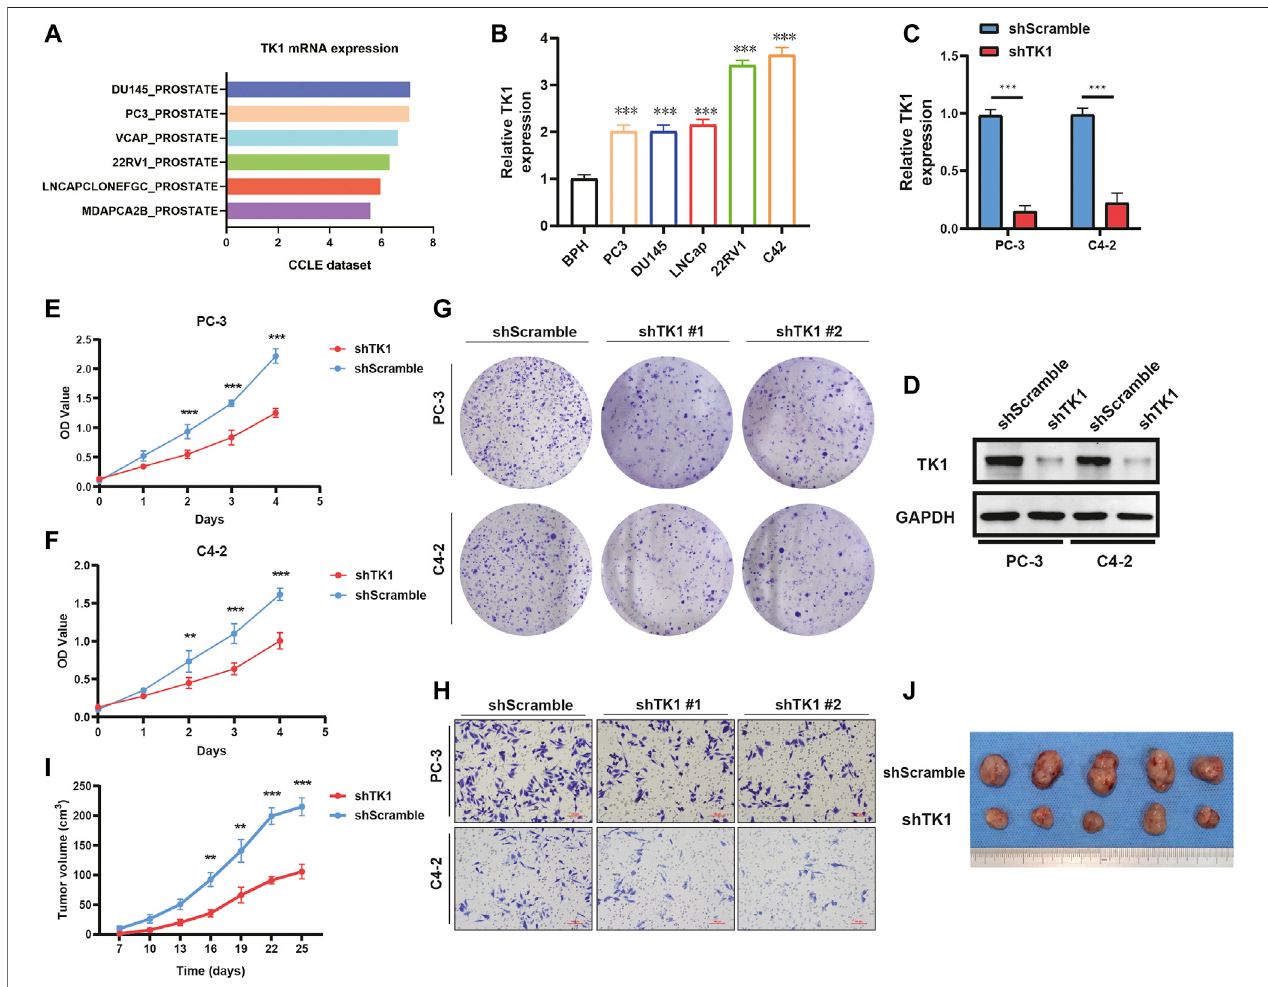
FIGURE 2 | TK1 ablation inhibits tumor cell growth both in vitro and in vivo . (A) TK1 mRNA expression of prostate cancer cell lines in the CCLE dataset. (B) TK1 mRNA expression in prostate cancer lines validated by qPCR. (C,D) TK1 knockdown ef fi cacy validated by qPCR (C) and Western blot (D) . (E,F) The cell proliferation capacity in shTK1 cells is signi fi cantly suppressed compared to control cells. Both PC-3 and C4-2 cell lines were applied. (G) TK1 silencing dramatically inhibits the colony formation of prostate cancer cells. (H) The migration ability in shTK1 cells is signi fi cantly inhibited compared to control cells. (I) Tumor growth curves of the TK1-silenced and control groups. (J) The photograph of tumors implanted with TK1-silenced PC-3 cells and control tumors from nude mice. ** p < 0.01, *** p < 0.001.